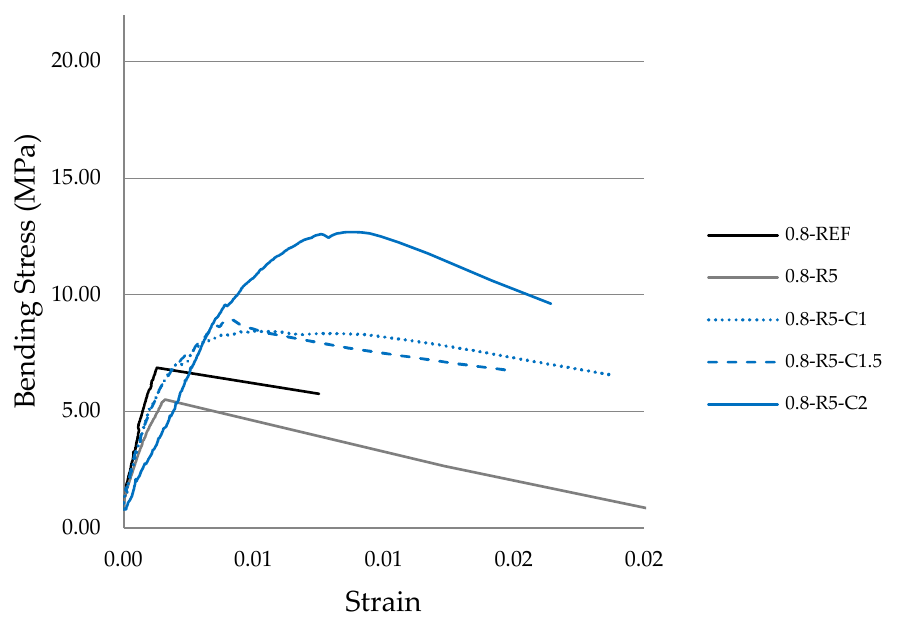
Figure 8. Experimental stress–strain relationship in bending tests on prismatic samples of the different mortar mixes (w/g 1 0.8).